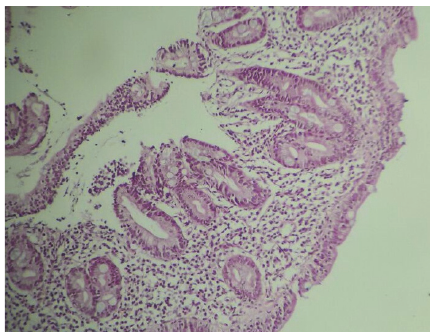
Figure 2: Total villous atrophy, increased number of intraepithelial lymphocytes, and crypt hyperplasia; Hematoxylin & Eosin × 100.